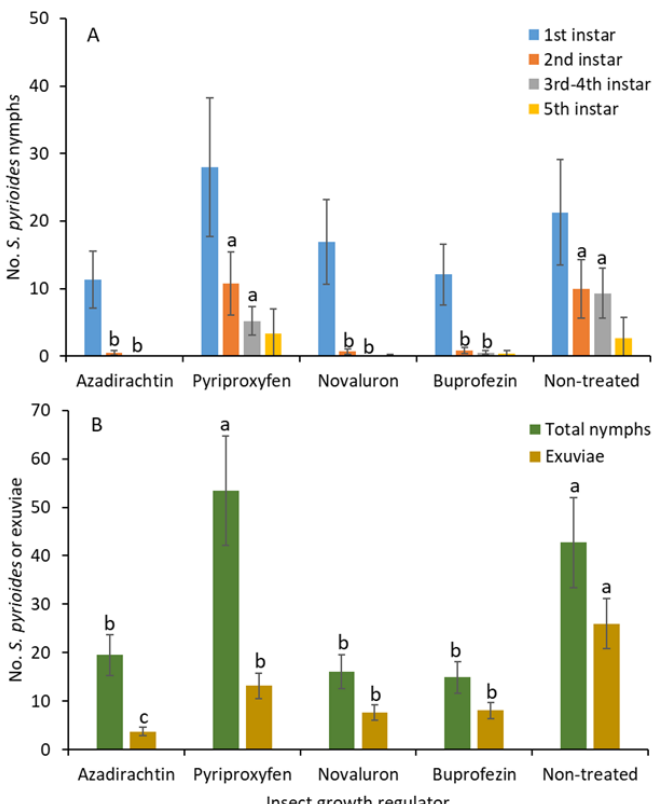
Figure 1. Least squares mean ( ± SE) numbers of various instars from S. pyrioides in ( A ) the first, second, third and fourth, and fifth instars and ( B ) the total nymphs and exuviae at 7 d posttreatment when IGRs were applied to implanted S. pyrioides eggs. The bars of the same fill color with the same letters are not significantly different (pairwise t- test, p = 0.05). Nonsignificant data have no letters.